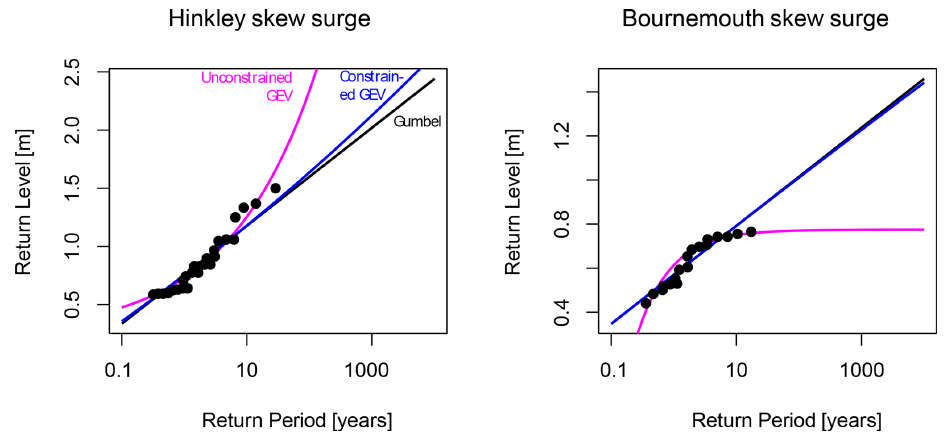
Figure 6. Illustrating a well-known issue with unconstrained GEV fit by MLE to annual maxima from a short record. The three different fits are described in the main